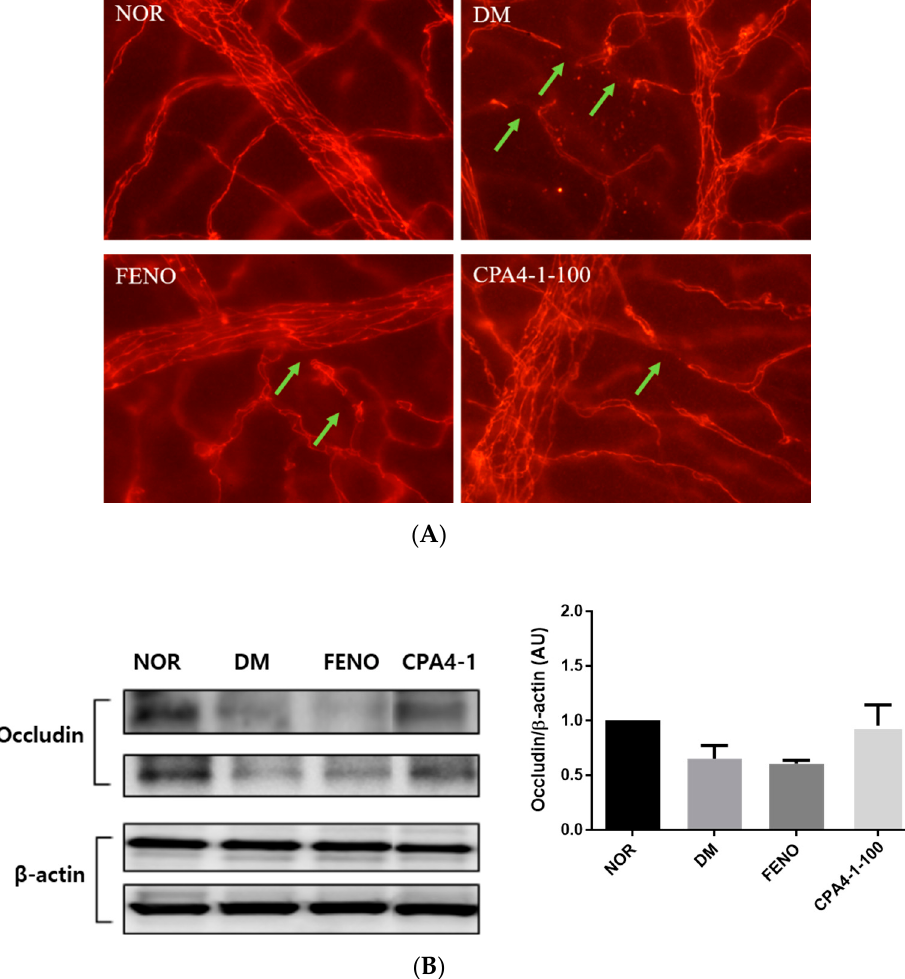
Figure 6. Effect of CPA4-1 on tight junction protein loss. ( A ) Immunofluorescence staining for occludin in trypsin-digested retinal vessels acellular capillaries (green arrow). ( B ) Expression of retinal occludin. The total protein was isolated from retinal tissues and subjected to Western blotting using occludin and beta-actin antibodies. Values in the bar graphs represent the mean (n = 2).